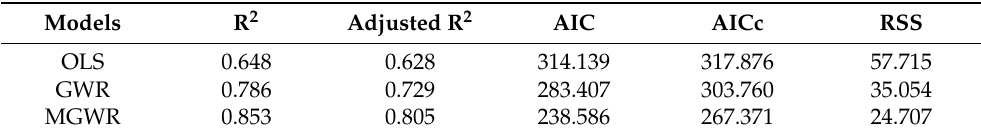
Table 2. Comparison of multiple